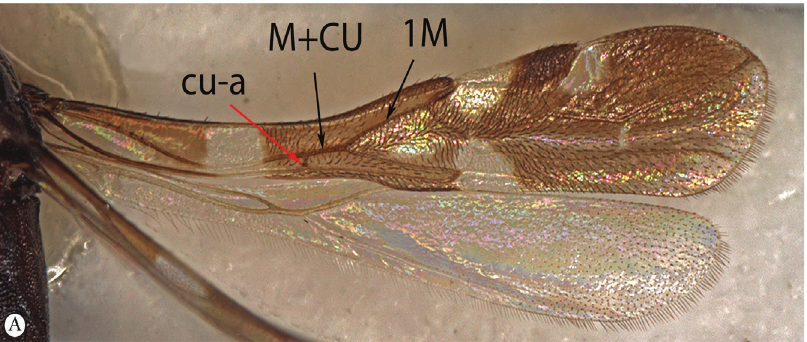
Nervulus (cu-a) of fore wing distinctly antefurcal to M+CU / 1M junction (A). Basal vein (1r-m) of hind wing absent, costal vein (1-SC+R) fused with mediocubital vein (1-M) (A) .................................................. Parana